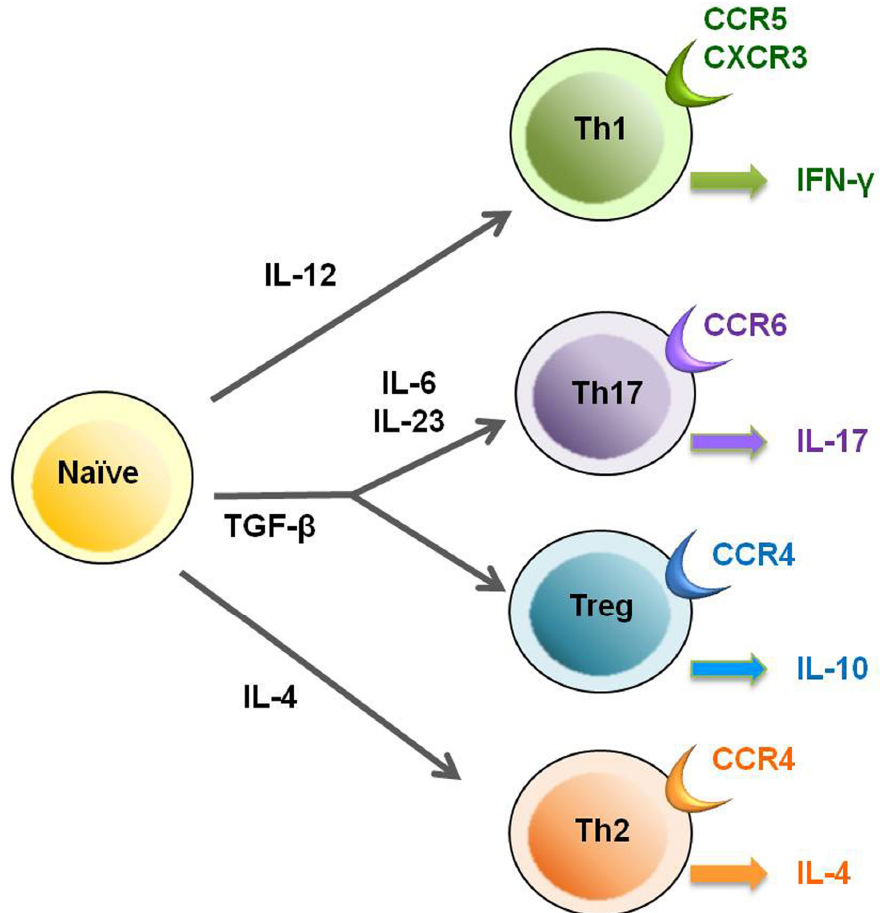
Figure 1. T cell subsets of CD4 + T helper cells. Th cells are differentiated from naïve CD4 + T cells into 4 major lineages: Th1, Th2, Th17, and T-regulatory (Treg) cells. Each Th subset exhibits characteristic functions, patterns of cytokine secretion, and expression of specific chemokine